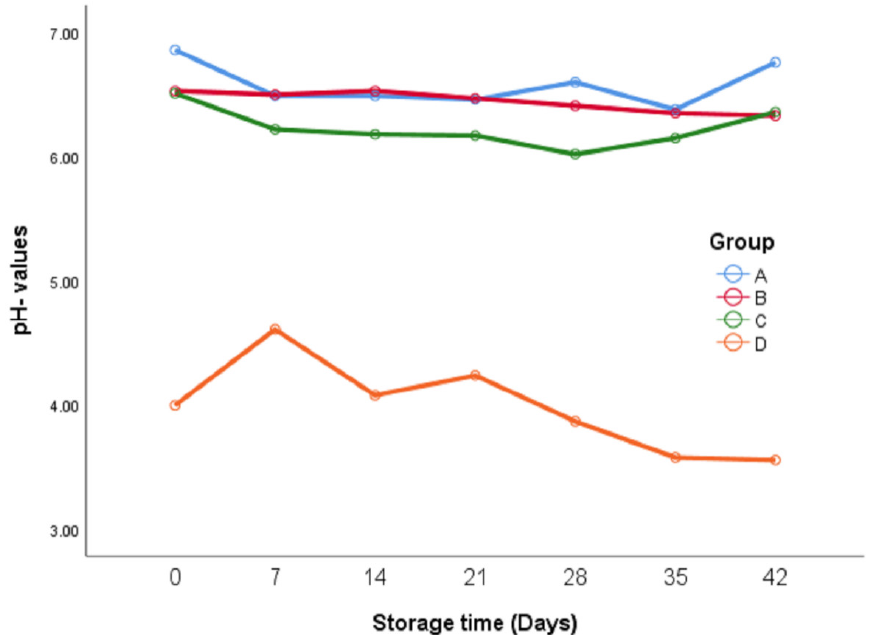
Figure 2. pH of fresh oregano at refrigerator temperature 4 °C during storage period (42 days). Group A: (Control group): (100% Fresh oregano leaves), Group B: (73.2% Fresh oregano, 15%